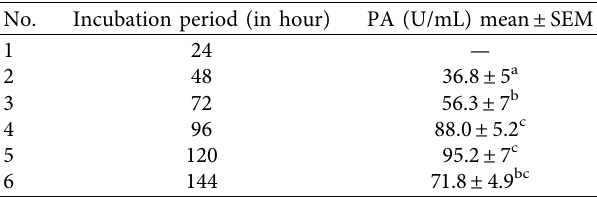
Figure 4: Screening of two agro-industrial residues for acid protease production from the filamentous fungal isolate Z1BL1. Mean is the average of three measurements. Different letters (a, b, c, d) designate significantly different means as determined by the SPSS test ( P < 0 . 001 ) ; temperature 30 ° C; initial media pH 4.5. Table 4: Effect of incubation period on acid protease production by the isolate Z1LB1.